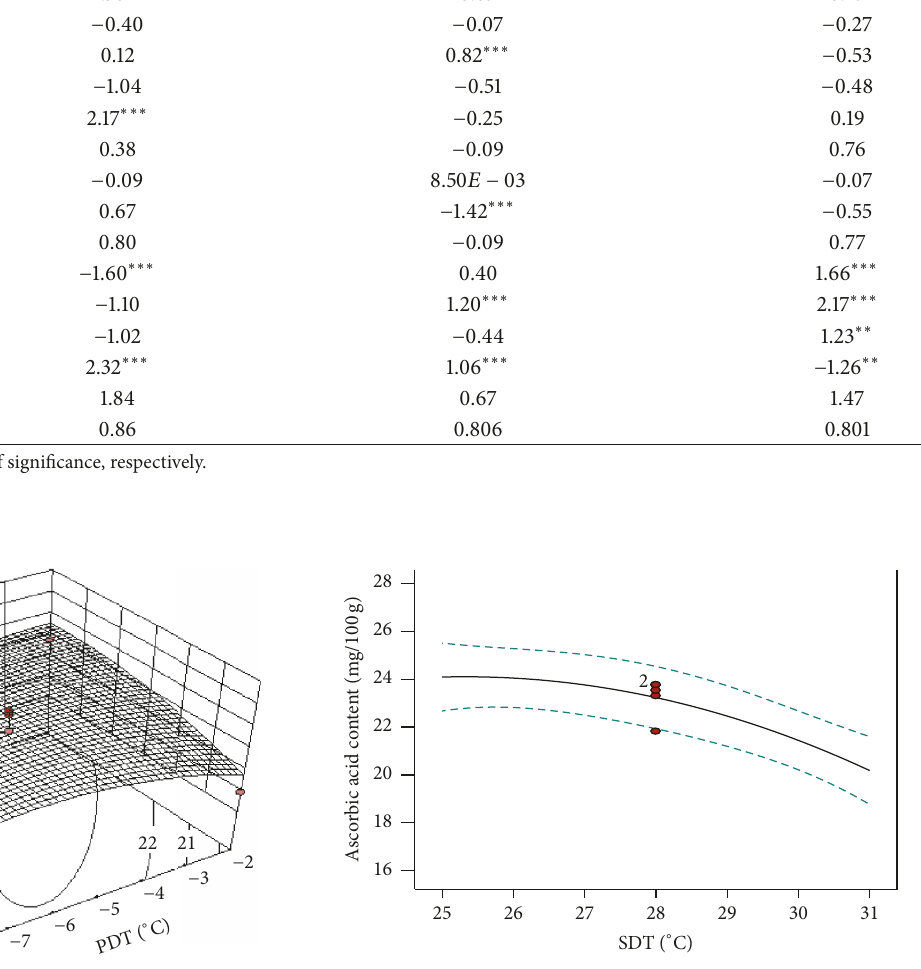
Figure 2: Effect of secondary drying temperature (SDT) on ascorbic acid